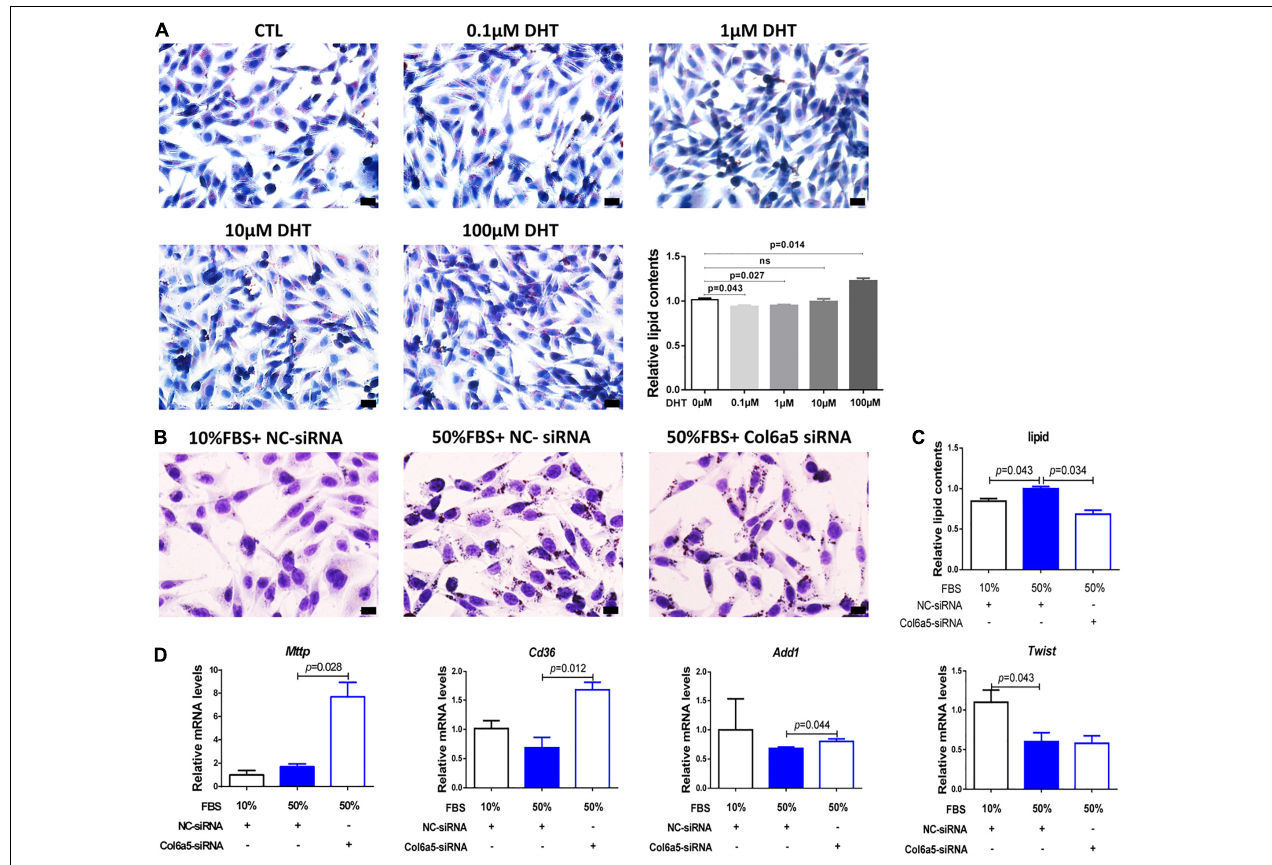
FIGURE 6 | Col6a5 -siRNA alleviated excess lipid accumulation in overnourished NCTC1469 cells. (A) Oil Red O staining and relative quantification of lipid concentrations in DHT-treated NCTC1469 cells; n = 3, scale bars = 20 µ m. NCTC1469, a mouse hepatic cell line. Cells were cultured in medium with DHT for 24 h; n = 3. The data are expressed as the mean ± SEM and were compared by Mann-Whitney U -test. (B) Oil Red O staining and (C) relative quantification of lipid concentrations in overnourished NCTC1469 cells; n = 3, scale bars = 20 µ m. (D) Relative expression of lipid metabolism-related genes in NCTC1469 cells from each treatment group; n = 3. The data are expressed as the mean ± SEM and were compared by Mann-Whitney U